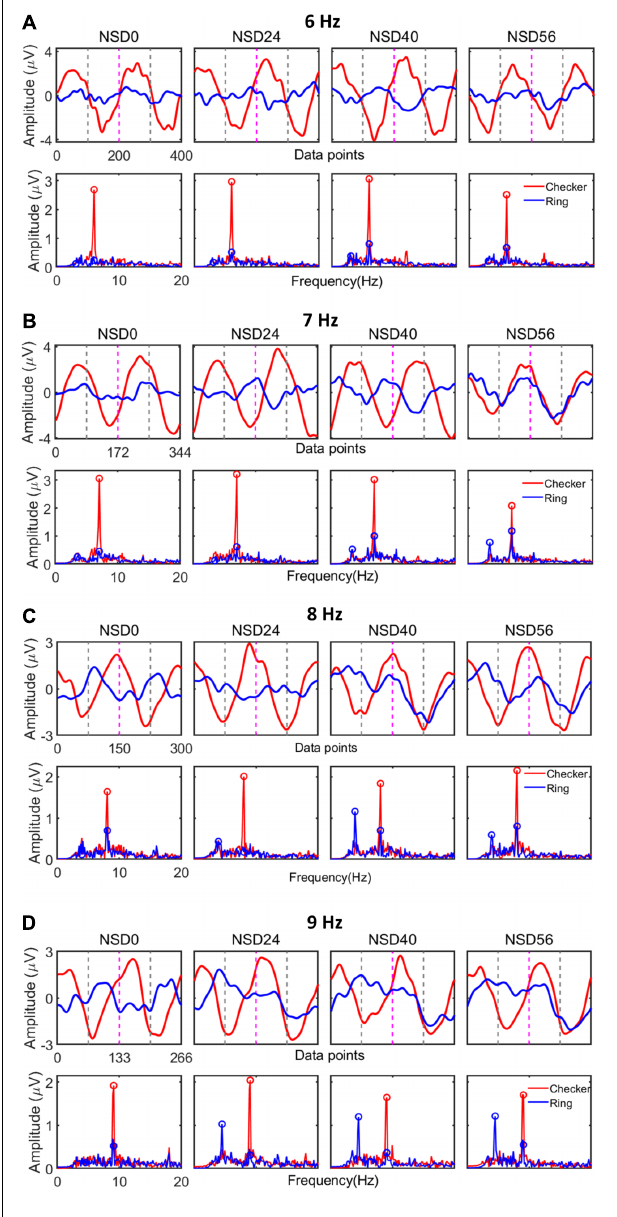
FIGURE 4 | Averaged SSMVEP waveform and corresponding power spectra of Subject S1 at different motion reversion frequencies (MRFs). (A) Averaged SSMVEP waveform and power spectra at an MRF of 6 Hz. (B) Averaged SSMVEP waveform and power spectra at an MRF of 7 Hz. (C) Averaged SSMVEP waveform and power spectra at an MRF of 8 Hz. (D) Averaged SSMVEP waveform and power spectra at an MRF of 9